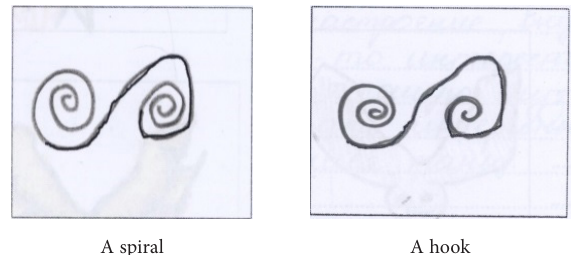
Figure 13. The creative task: interpretation of Fragment 2 – tools (source: testingmom.com, 2020) The associations of Fragment 2 with shoes were presented by 3.5% of the research par- ticipants, whereas the frequency of this link went up to 8.7% in the process of interpretation. The Latvian students provided the biggest number of associations and interpretations using the motif of shoes (Table 4). While interpreting the fragment, most frequently shoes had a heel, although sneakers, clown shoes or a joker’s shoe were also provided by the participants (Figure 14).